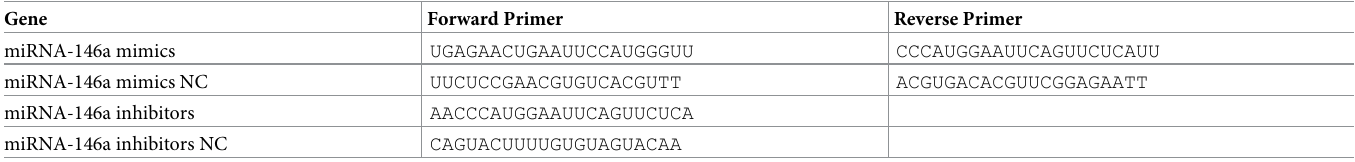
Table 1. Sequences of miRNA-146a mimics and inhibitors.